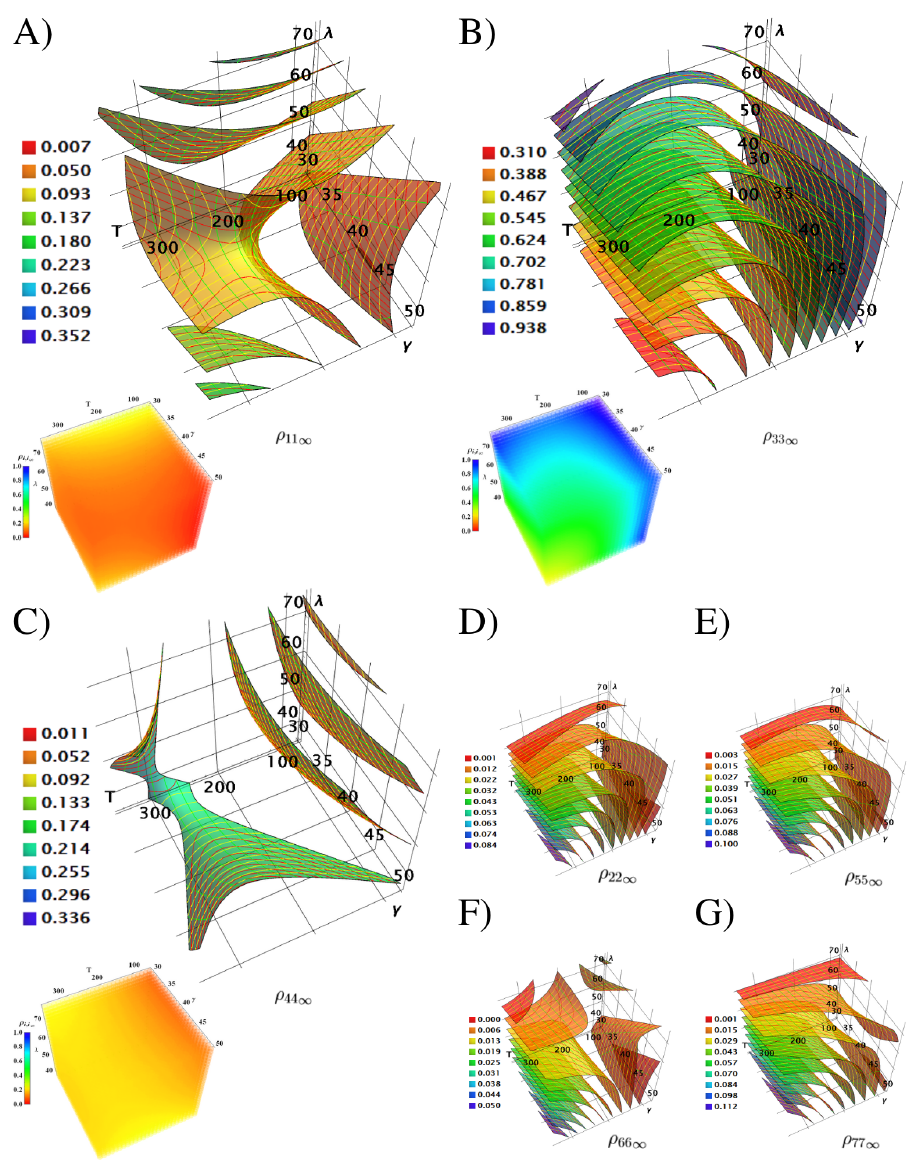
Figure 8. Contour plots for the equilibrium populations ρ ii behavior in color for each BChl as function ∞ of T , λ k , γ k . ( A – C ) those with the largest variability, and ( D – G ) those with the lowest. Insets are alternative equivalent plots in transparent colors in the analysis region. Curves on the contours are cuts with constant T (green), λ k (red) and γ k